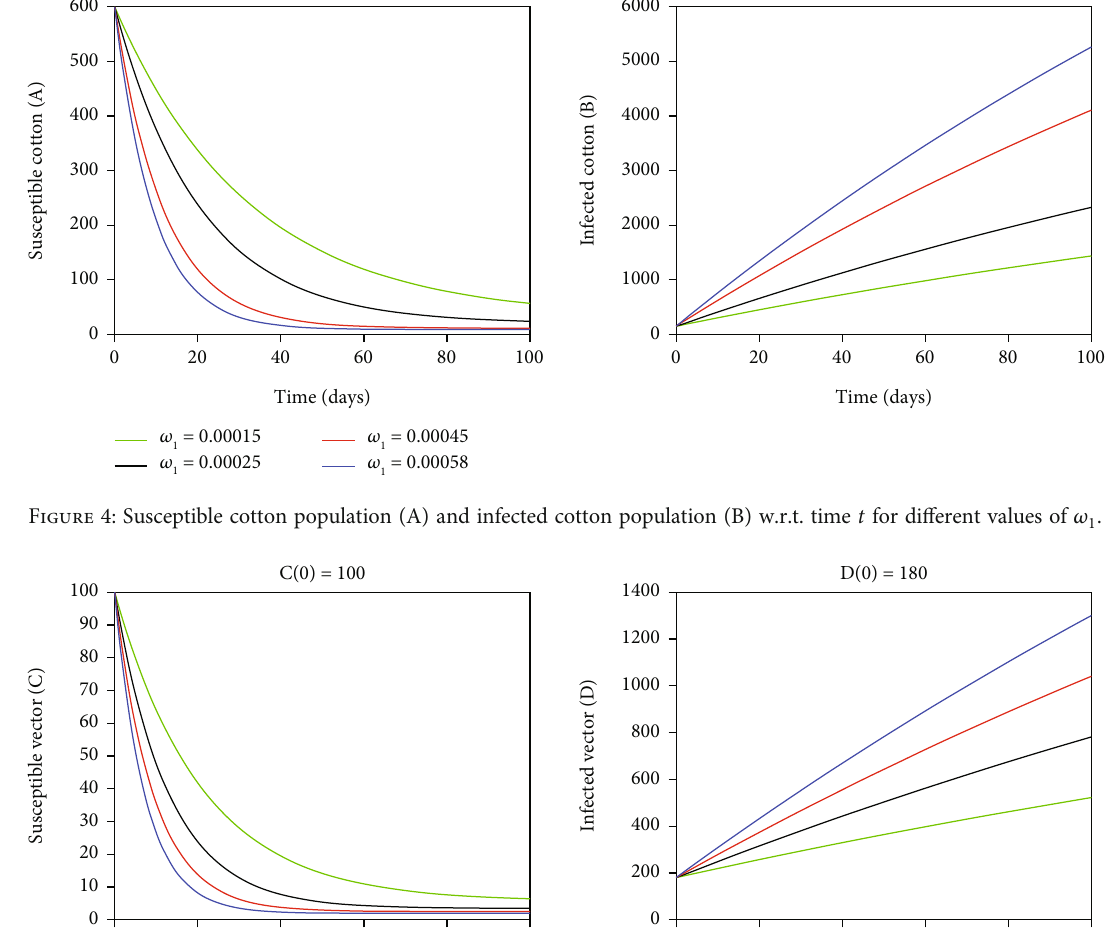
Figure 5: Susceptible vector population (C) and infected vector population (D) w.r.t. time t for di ff erent values of ω